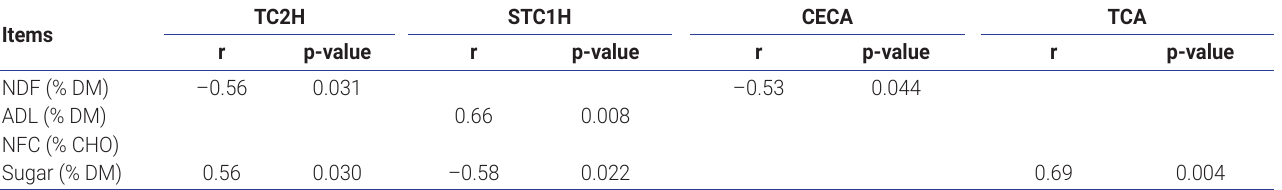
Table 2. Correlation between FTIR carbohydrate structures and the carbohydrate portions of the chemical profile of canola seeds Items